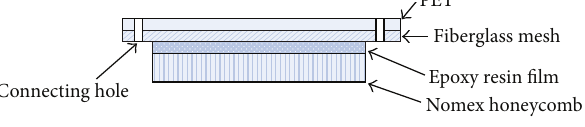
Figure 1: Structure of MLI.